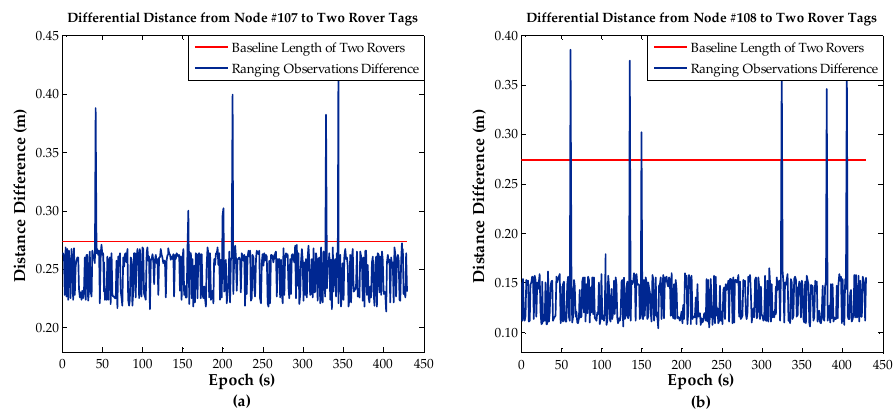
Figure 10. ( a ) The difference of ranging observations (from #107 to two rovers); ( b ) The difference of ranging observations (from #108 to two rovers).